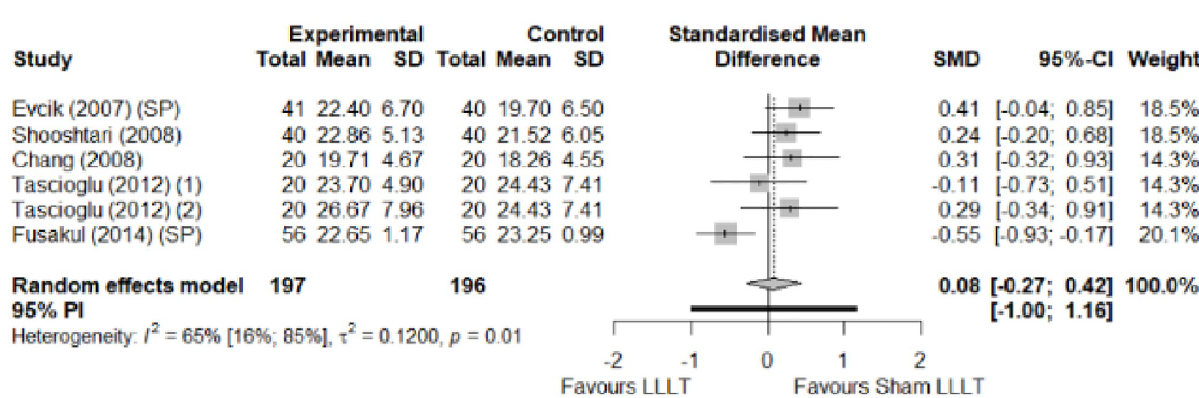
Fig 11. Analysis—Electrophysical modalities versus placebo (grip strength). Studies with more than two intervention groups (different modalities, treatment doses, or symptom classification) were numbered as (1) and (2). Modalities delivered with a splint were marked as (SP).